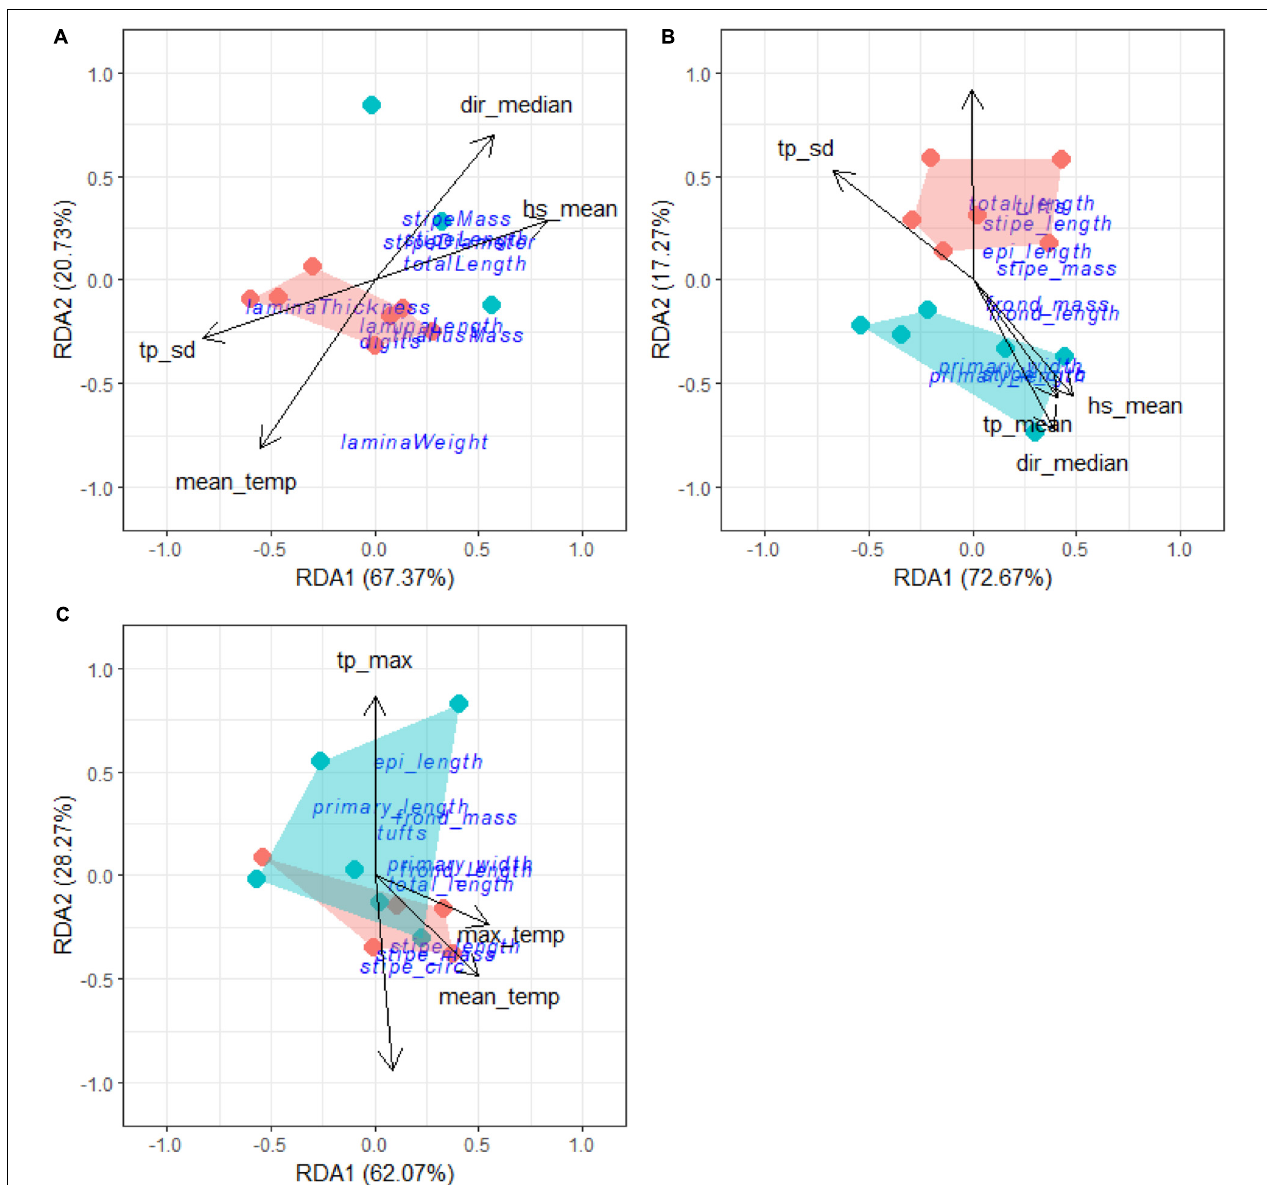
FIGURE 12 | RDA output for L. pallida (A) , deep E. maxima (B) and shallow E. maxima (C) . The blue cluster represents sites from the western region and the red represents sites from the eastern